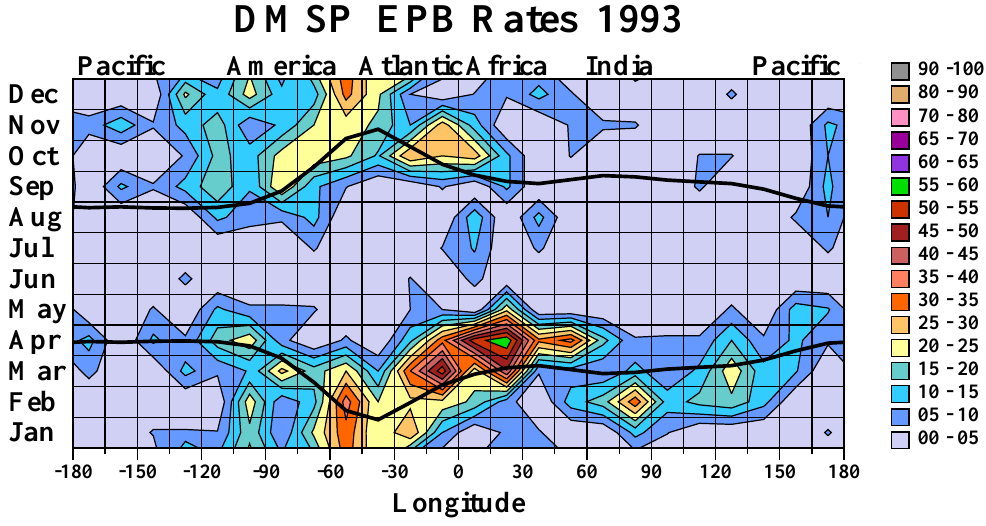
Fig. 7. EPB rates for transition year 1993 were highest (50%–60%) in the Atlantic-Africa sector during March–April.